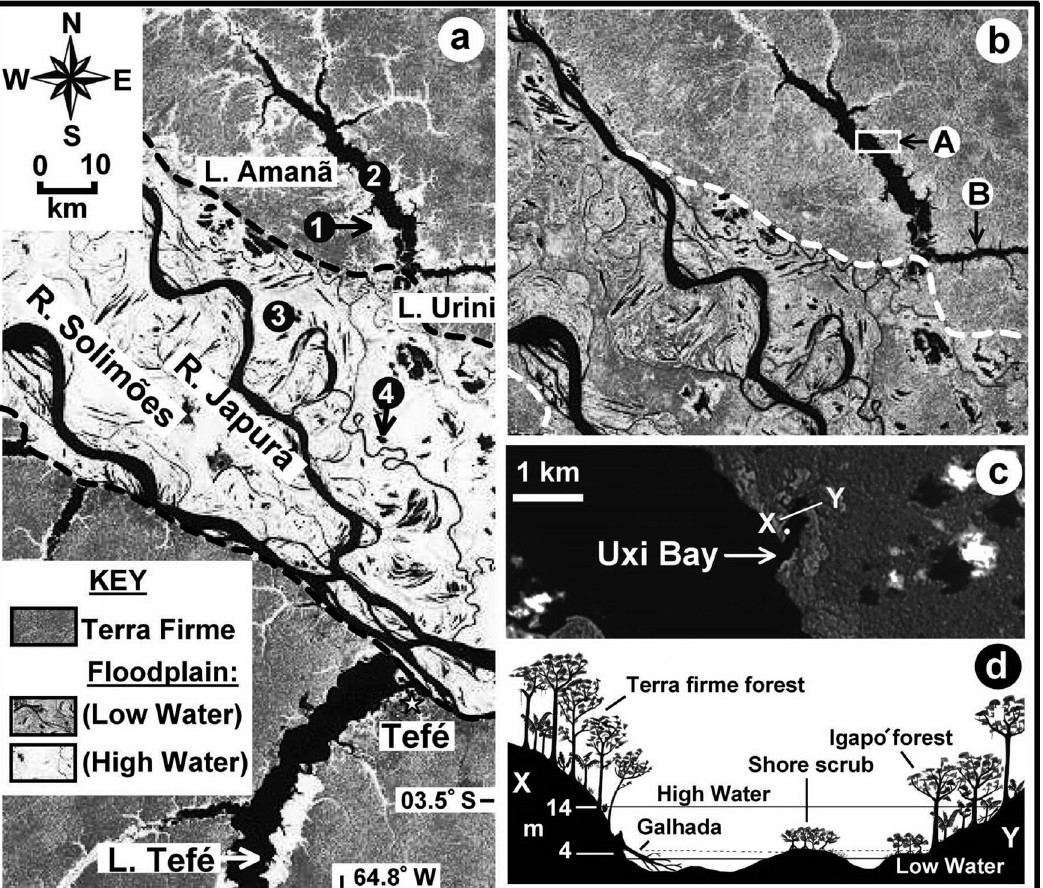
Fig. 1. NASDA JERS-1 radar image of the Tefé region, Brazil: (a) high water (May 1995); (b) low water (September 1995). Flooded forests appear white, illustrating the maximum extent of the seasonal flooding. The area between the dotted lines is whitewater floodplain. R. Solimões is the local name for the Amazon River. Discus occur in the following habitats: 1, blackwater flooded forest ( igapó ), 2, blackwater lakes, 3, whitewater flooded forest, 4, whitewater floodplain lakes. Study are marked A (Uxi Bay) and B (lago Urini). Inset (c) shows Uxi Bay from Landsat TM-5 image, 1998. Here, the white dot represents the locality of a large discus colony and the line X-Y refer to the cross-sectional schematic (d). In (d) the dotted horizontal line represents the water level at the beginning of 1998 samples. The 4 m water-level (see also Fig. 2) marks the lower levels of shore scrub growing on beaches and sand bars. Shore scrub is dominated by Coccoloba ovata Benth. and Symmeria paniculata Benth.